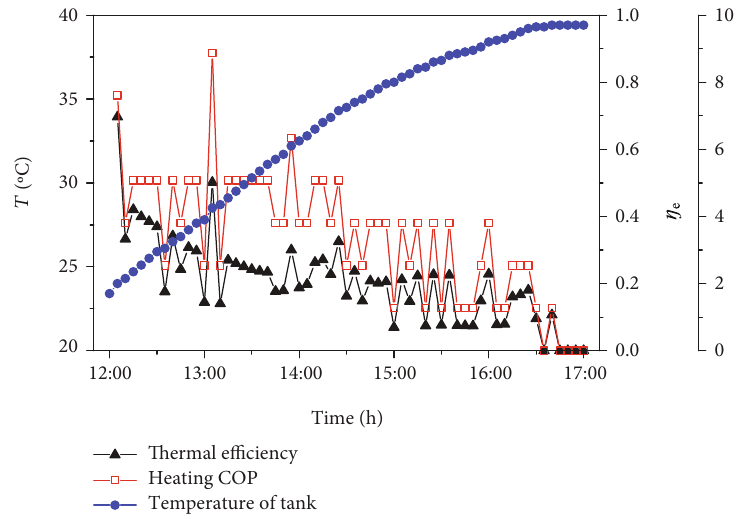
Figure 6: Curves of the heating COP, the temperature of the tank, and thermal e ffi ciency.